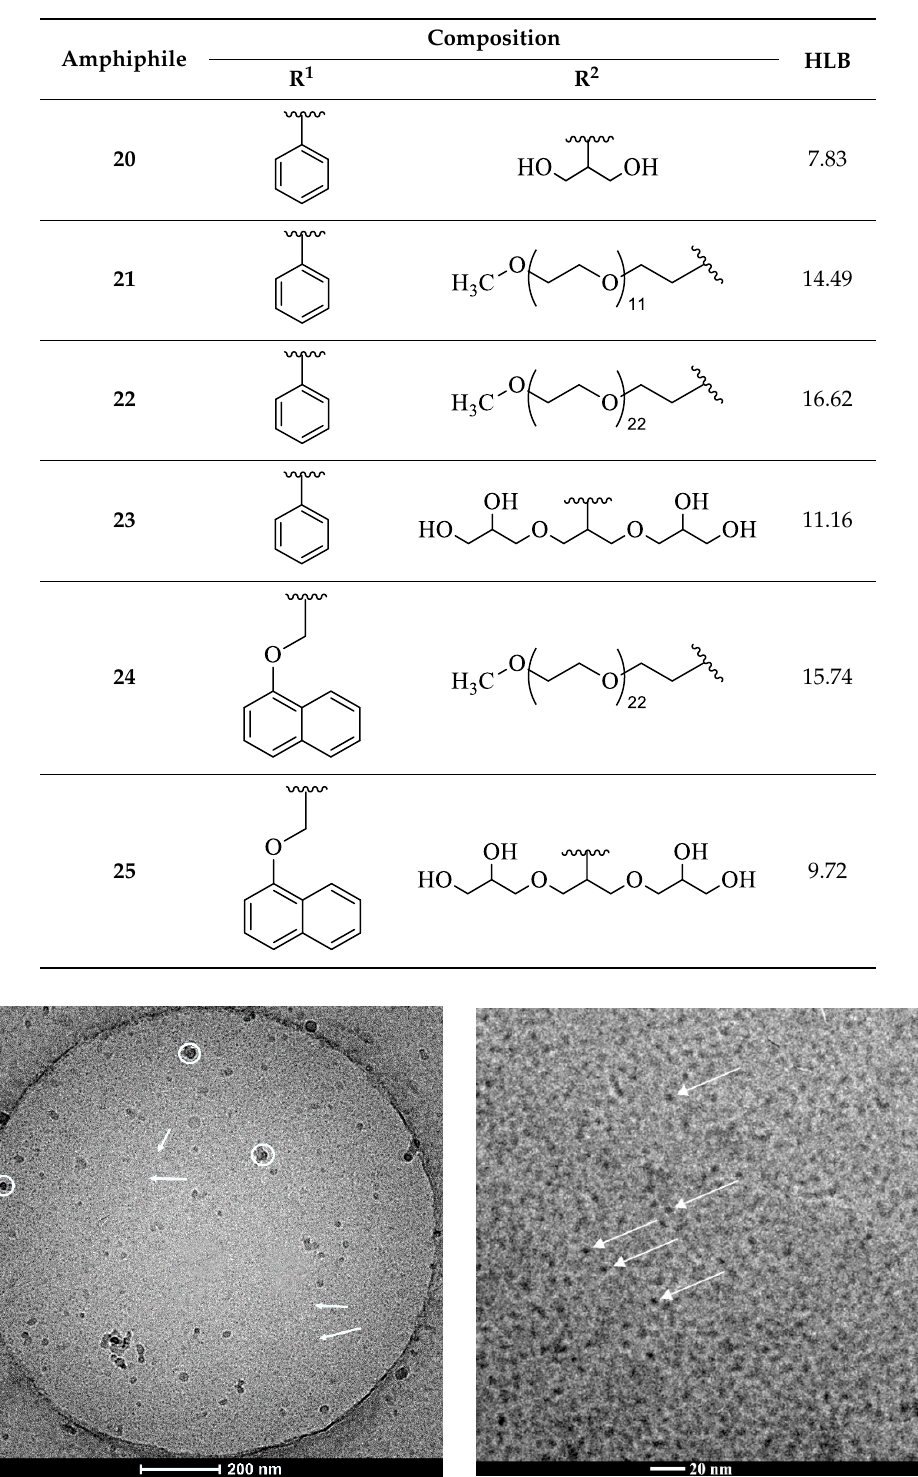
Table 3. Particle size distribution profile of amphiphile self-assemblies above the CAC in aqueous solution as measured by dynamic light scattering (DLS) at 25 °C. Figure 3. Cryo-TEM image of amphiphile 25 showing micellar assembly (indicated by arrows) and surface contamination (indicated by white circles) at different magnification.